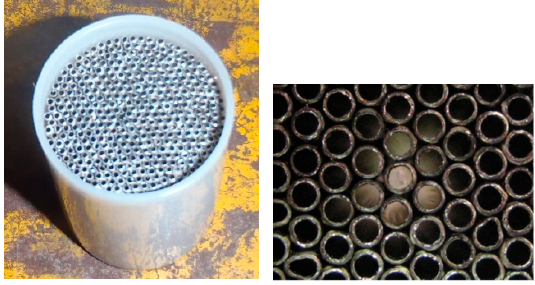
Figure 3. Photograph showing 289 syringe needles packed into a circular tube.